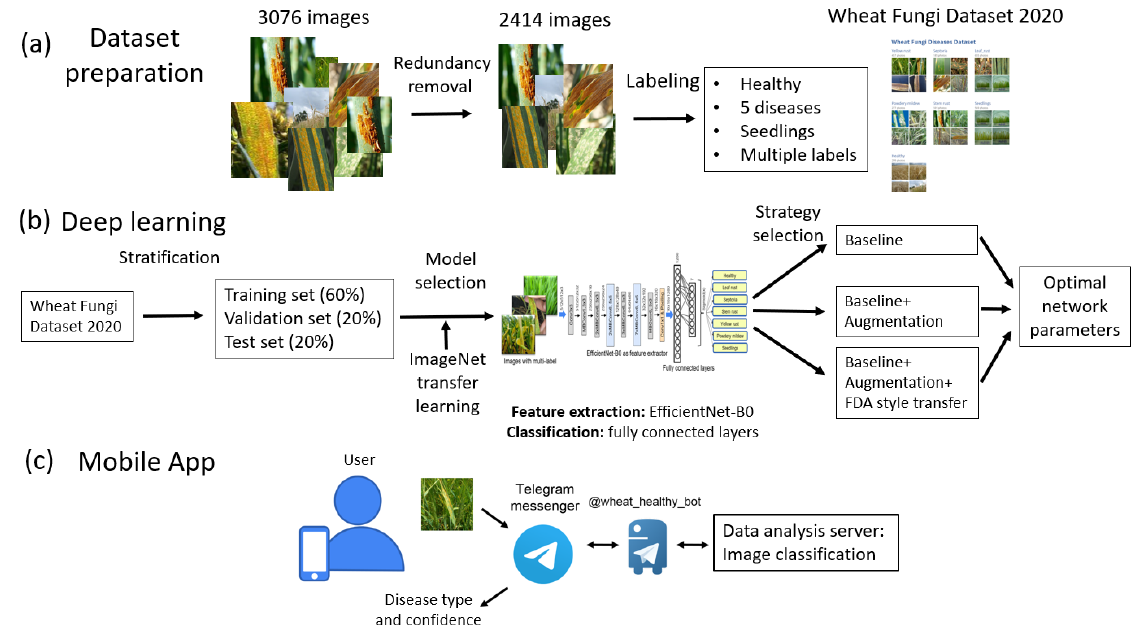
Figure 2. Overview of the approaches developed in this work for wheat fungi diseases recognition: ( a ) image dataset preparation, ( b ) deep learning neural network design and training, and ( c ) mobile application for plant monitoring using Telegram